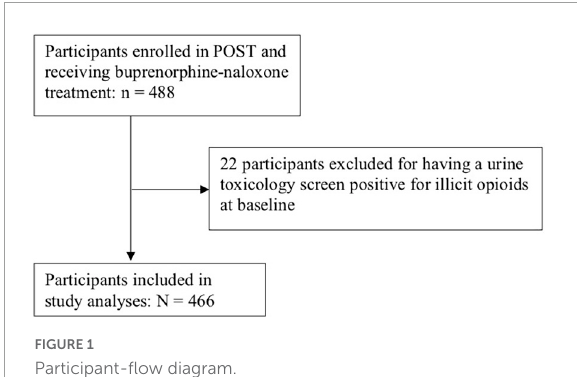
FIGURE1 Participant-flow